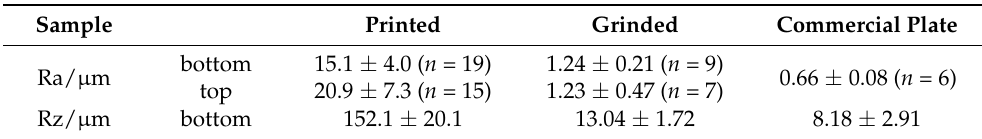
Table 1. Surface roughness was measured as arithmetic mean deviation of each sampling point on one surface of a sample (Ra) or as the maximum detected peak-valley value on the top and bottom surfaces (Rz) of the printed ceramics before and after